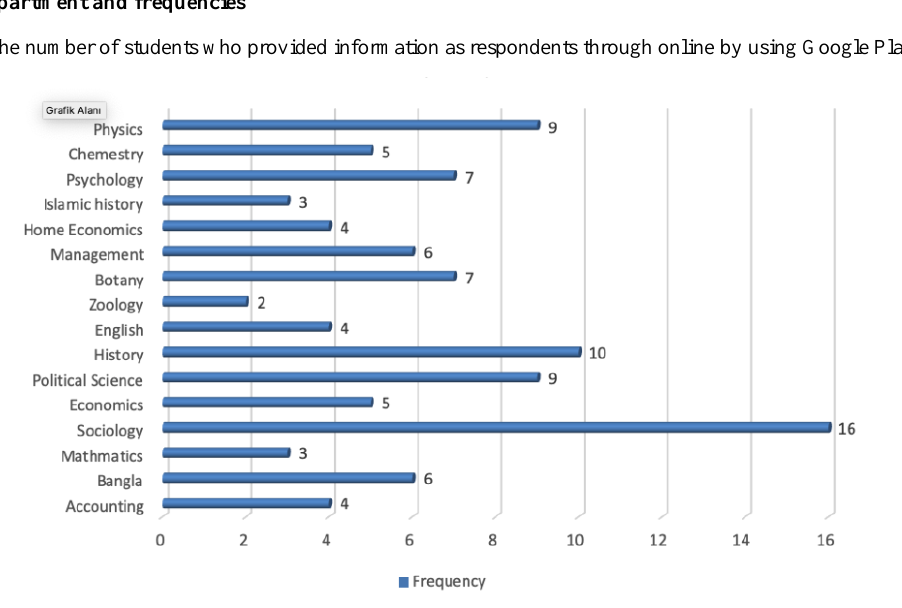
Figure 2: Number of students who provided information as respondents through online by using Google